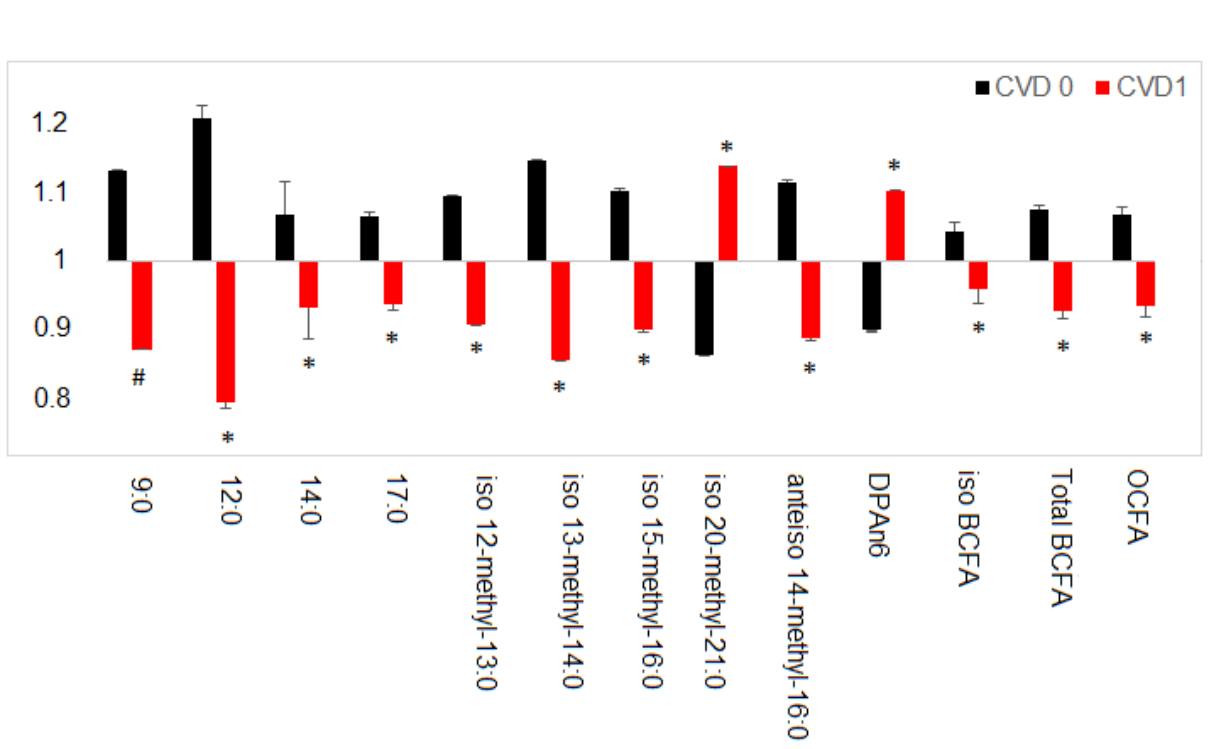
11 of 18 Figure 3. Heatmap generated basing on the serum profile of 55 fatty acids in healthy control (HC, red) and Tx patients. Rows: fatty acids; columns: individuals. Color key indicates fatty acid expression value: dark blue: lowest; dark red: high- est. HC – healthy controls; Tx(1)-patients up to one month after the procedure; Tx (12)-patients between 1 month and the first year post-transplant; Tx (>12)-patients in their consecutive years post-transplant. AdA-adrenic acid; ALA- α -linolenic acid; ARA-arachidonic acid; BCFA-branched chain fatty acids; CPOA2H-cyclopropaneoctanoic acid 2-hexyl; DGLA-di-